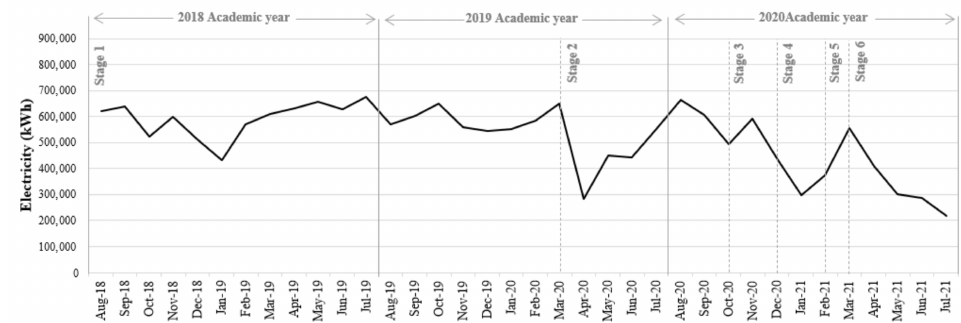
Figure A3. Electricity consumption of the office type during AY2018 to AY2020.